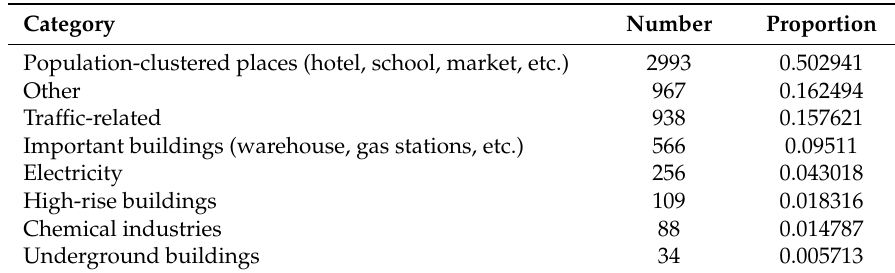
Figure 4. Annual summaries for fire records (2002–2010) and the relationship with population growth. Moreover, Figure 4 shows that in the latest years, fire frequency per capita has decreased more than fire frequency. Table 1 also shows that human-caused fires play an important role in explaining Table 1. Statistical summary for fire categories. ignitions and places of interest (POI), and areas, where population is clustered, represent the main potential causes of fire risk, evidenced by the high proportion of fire occurring in those places, with the exception of fires associated with chemical industries, traffic, and electrical appliances.